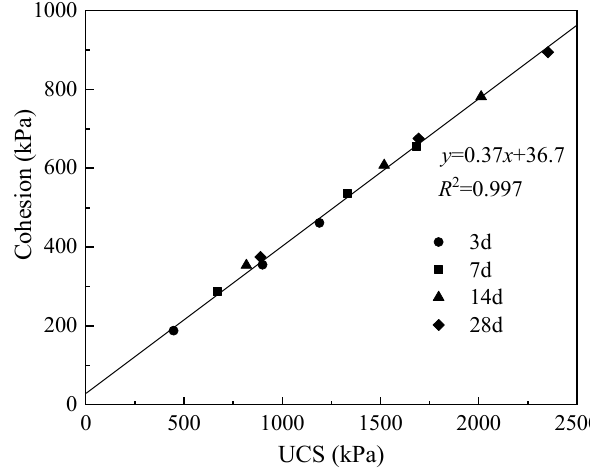
Figure 14. Correlation between the cohesion and UCS.